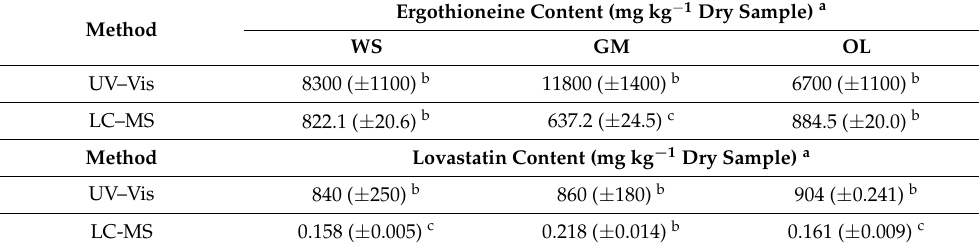
Table 4. Ergothioneine and lovastatin content of P. citrinopileatus mushrooms cultivated in three substrates, wheat straw (WS), grape marc (GM), and olive by-products (OL) by using UV–Vis and